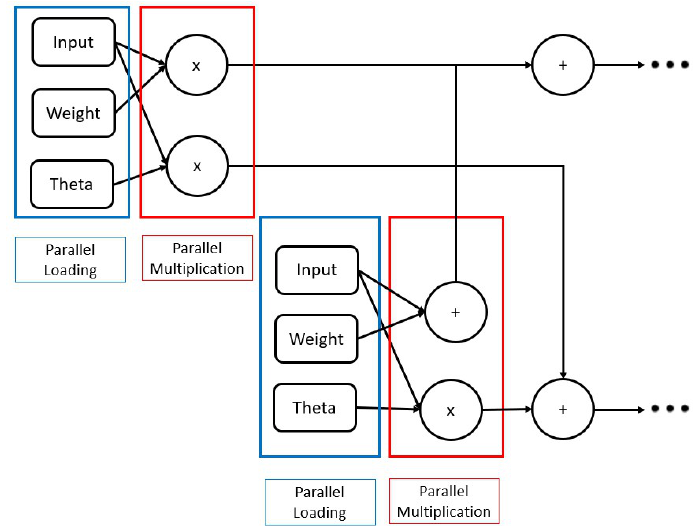
Figure 4. IP design for BRAM and